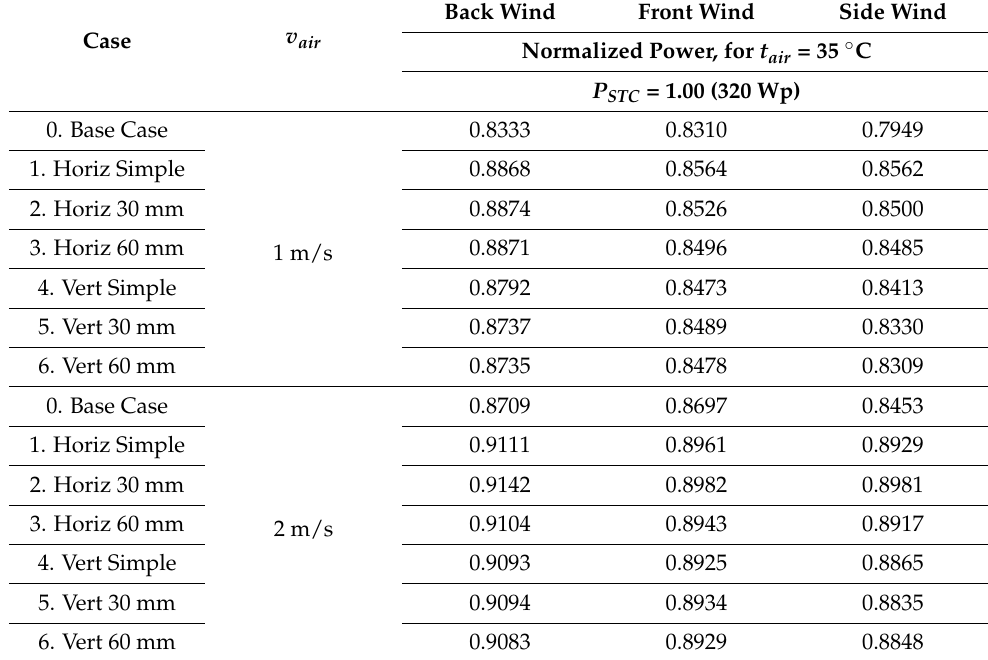
Figure 13. Normalized power production for side wind , v side = 1 m/s, t air = 35, G = 1000 W/m 2. Table 6. Normalized power production of the PV panel for each model